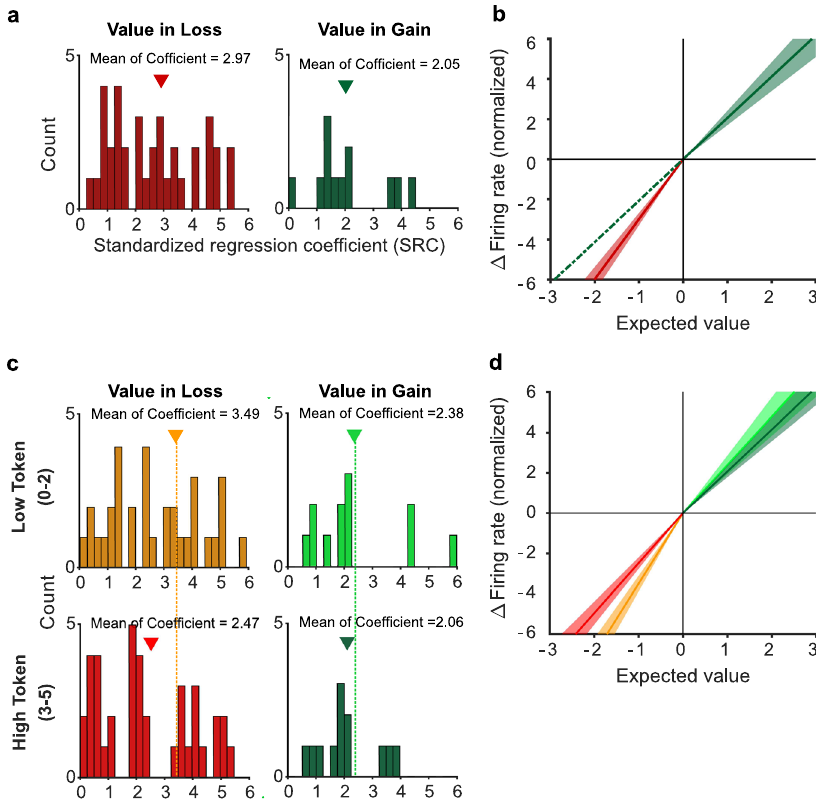
Fig. 4 Gain-value and Loss-value neurons exhibit differential sensitivity to value change in the gain and loss context. a , b Neuronal sensitivity to gain and loss estimated by linear regression of fi ring rates against expected option value of Loss-value neurons ( n = 39) in loss-context trials; and for Gain- value neurons ( n = 12) in gain-context trials. See “ Methods ” section for details of the neuron selection. a Distribution of the standardized regression coef fi cients (SRC). For cross-context comparison, the absolute value of SRCs (|SRCs|) were plotted. Each count represents one neuron. Inverted triangle: mean of the distribution. b The change in fi ring rate of Loss and Gain value neurons as a function in Δ EV (line: mean SRC value of the distributions shown in a ; shaded region: ±SEM) in the loss-context and gain-context, respectively. Note that the slope of the red line is steeper than the slope of green line ( p = 0.053, one-sided permutation test), indicating that Loss value neurons are more sensitive to EV change than Gain value neurons, mirroring the pattern observed from behavior (Fig. 2b). c , d Changes in neuronal sensitivity to gain and loss as a function of start token level was estimated by performing linear regression of fi ring rates against expected option value separately for low and high start token level. c Distribution of the |SRCs| of Loss Value neurons in loss-context and |SRCs| of Gain Value neurons in gain-context, split by start token levels. Each count represents one neuron. Inverted triangle: mean of the distribution. d Mean slope of regression based on the SRCs from c . Note that for both gain-contexts and loss-contexts, the slope becomes shallower as the token level increases, consistent to the pattern observed from behavior (Fig. 2b). b , d Loss value neurons and Gain Value neurons in loss-context and gain- context, are colored in red and green, respectively. Color gradients represent results from trials with different start token levels (light: low [0 – 2]; dark: